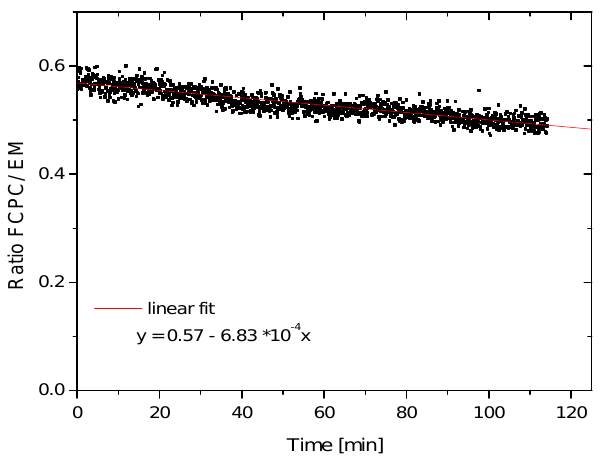
Fig. 6. Counting efficiency of the FCPC in comparison with the electrometer (ratio FCPC/EM) measuring 8-nm silver particles at 37 ◦ C | 10 ◦ C. The red line displays the linear trend.